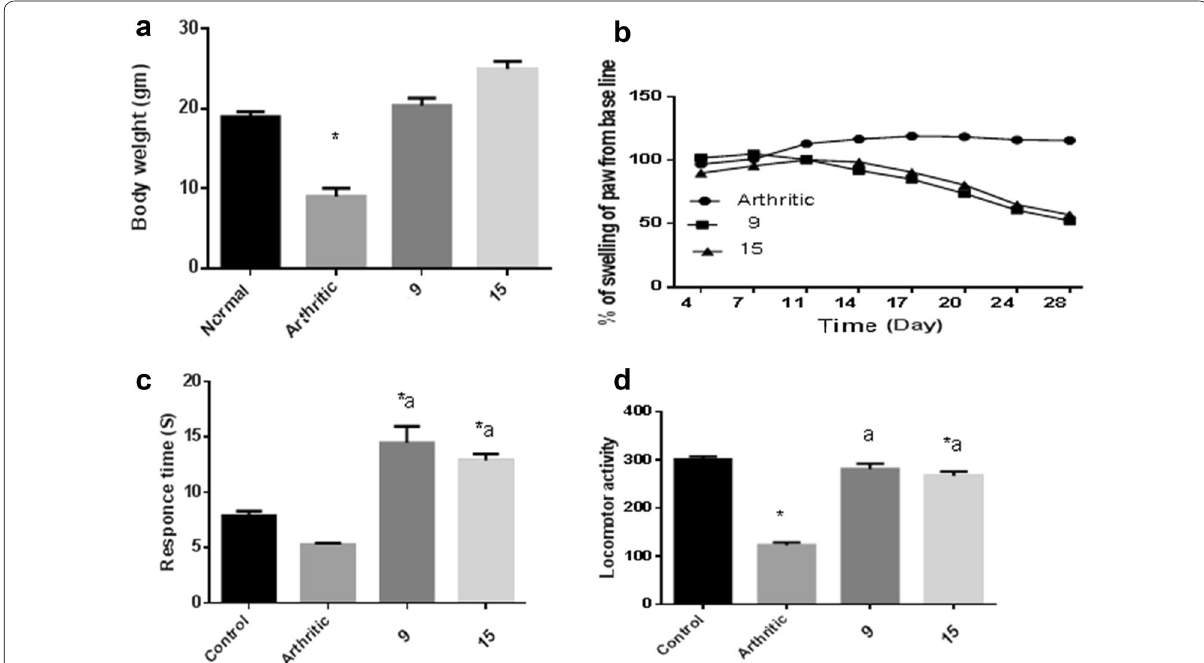
Fig. 4 a Changes in body weight of CFA‑induced RA in rat with compound s 9 and 15 . b Effect of test compounds (50 mg/kg) on CFA‑induced arthritis in rats with compounds 9 and 15 . c Effect on hotplate time response with compounds 9 and 15 . d Effect on spontaneous motor activity in CFA rats with compounds 9 and 15 . Data represent the mean versus CFA group (P 0.05) ≤